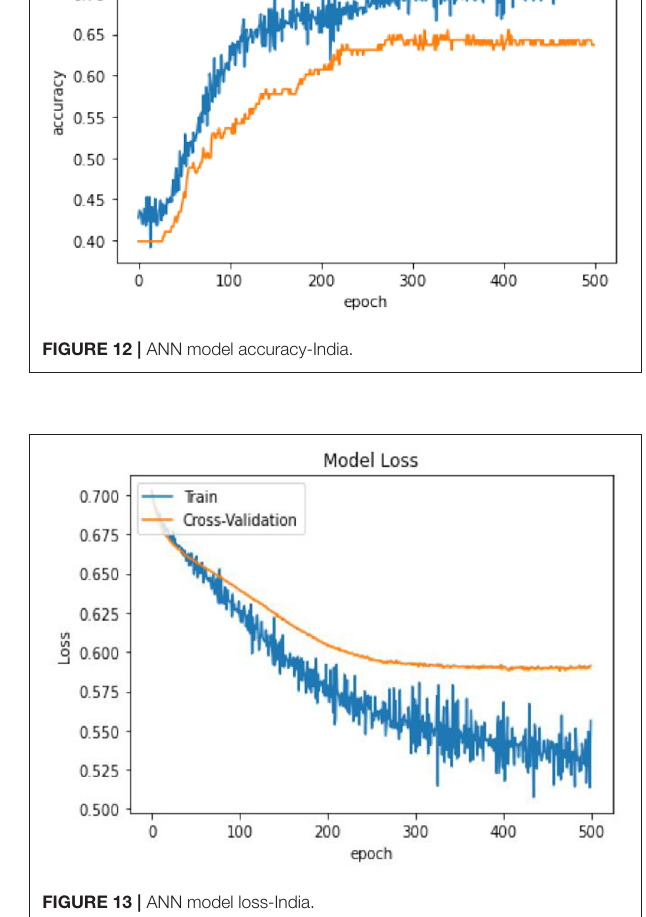
FIGURE 13 | ANN model